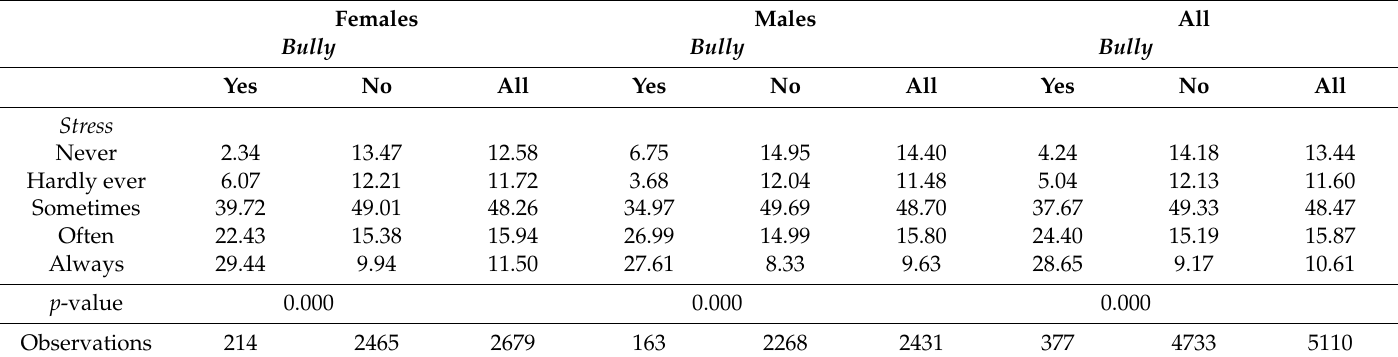
Table 2. Cross tabulations of stress and bullying by gender and overall (%). Females Males All